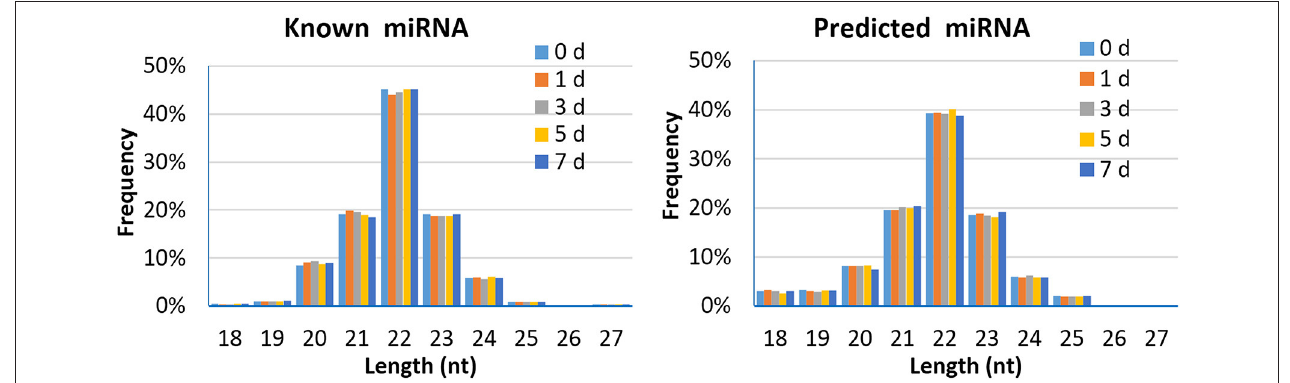
FIGURE 1 | Length distribution of the mapped known miRNA and predicted miRNA in peripheral blood of dairy cows.